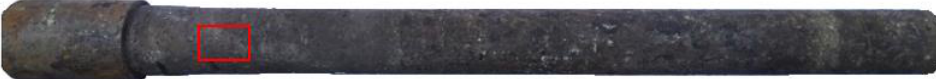
Figure 5. Sampling area of failed tubing.